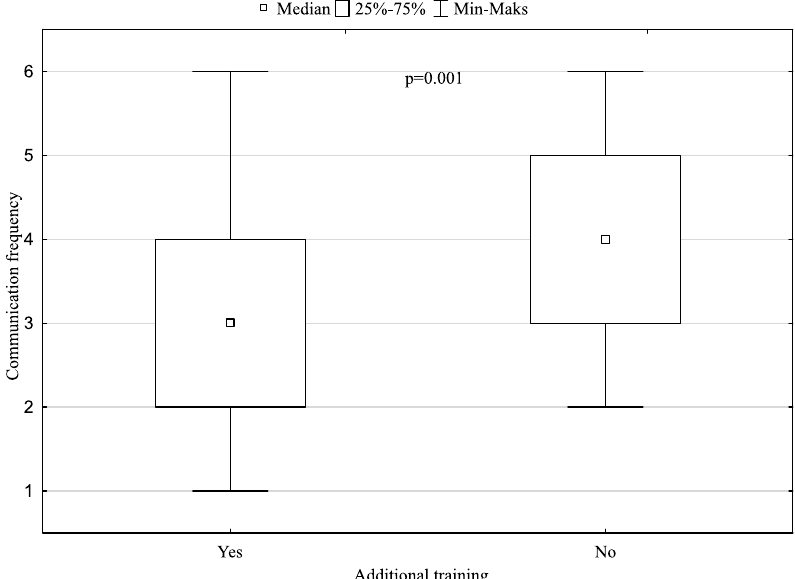
Figure 4. Frequency of communication with an elderly person in suicidal crisis according to the training needs in the field of